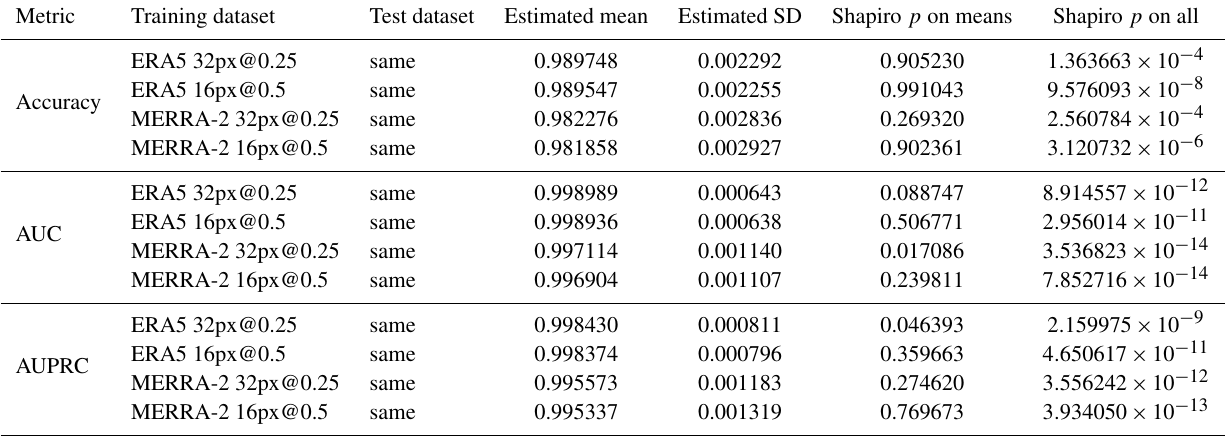
Table A2. The estimation of the values of the metrics based on iterative cross-validation. The training and test datasets come from the same image set (intercomparison). The column “Shapiro p on means” refers to the p value of the Shapiro–Wilk test computed on the mean of each iteration, whereas “Shapiro p on all” refers to the p value computed on all the values of the